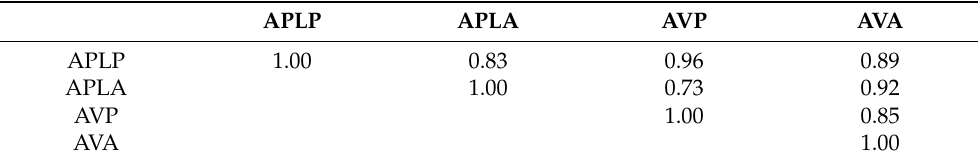
Table 4. Correlation results for the anterior-posterior direction (33 subjects).